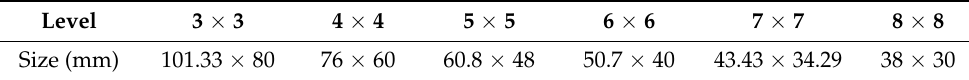
Table 2. The target size (length × width) at each level of the experimental condition.